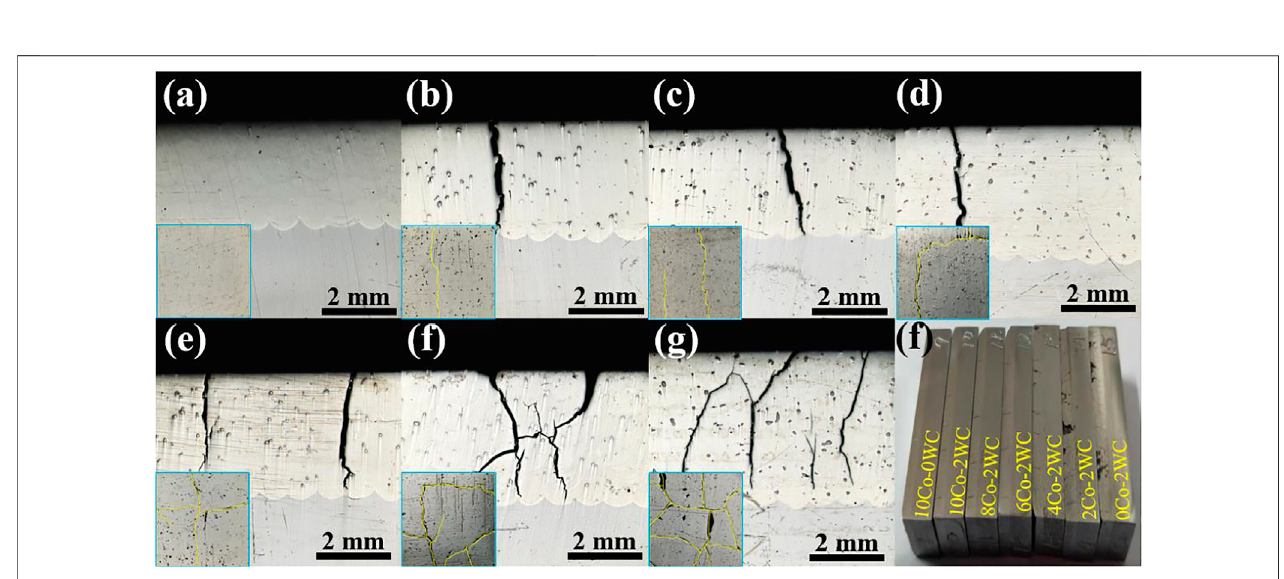
FIGURE7| Crackingcharacteristicsofthesamplesinthebuildingandscanningdirections. (A) 10 – 0sample; (B) 10 – 2sample; (C) 8-2sample; (D) 6 – 2sample; (E) 4 – 2 sample; (F) 2 – 2 sample; and (G) 0 – 2 sample.